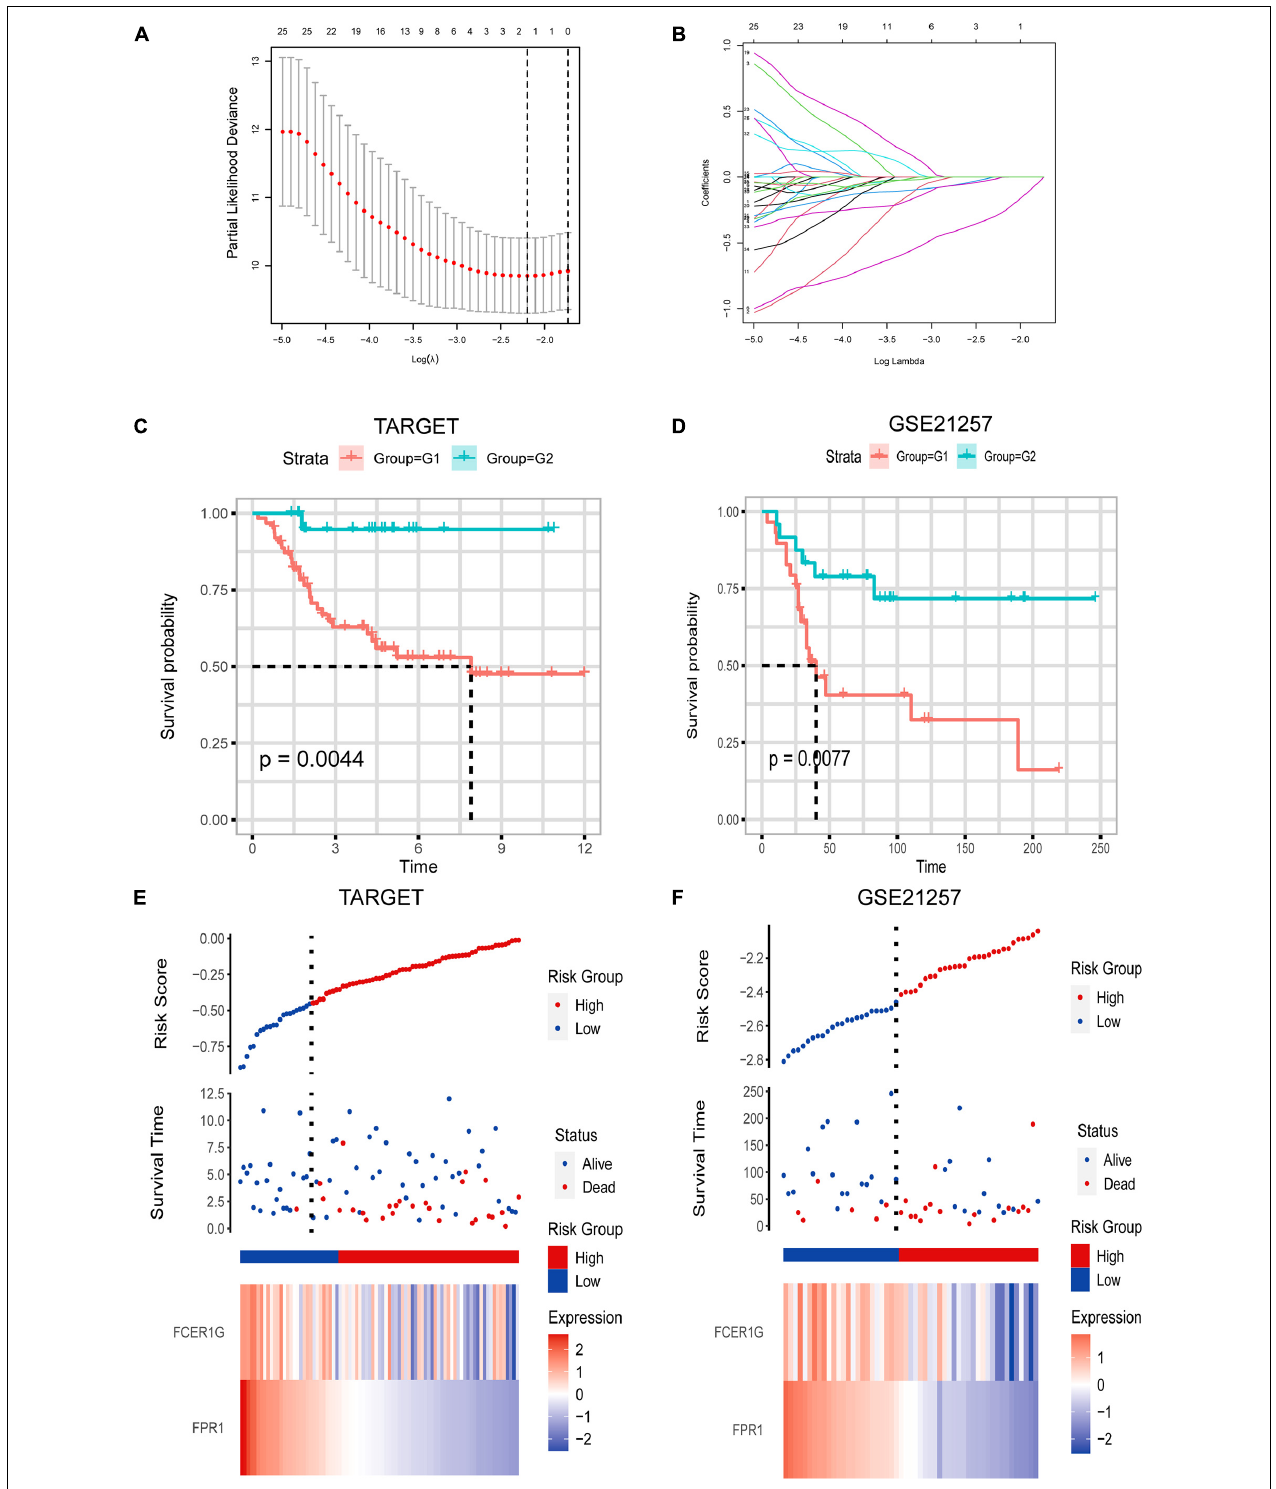
FIGURE 6 | (A,B) Lasso Cox analysis uncovered two genes most associated with OS in TARGET dataset. (C,D) Kaplan–Meier curves of OS for LGG patients based on IPS in TARGET cohort and GSE21257 cohort. (E,F) Risk scores distribution, survival status of each patient, and heatmaps of prognostic four-gene biosignature in TARGET and GSE21257